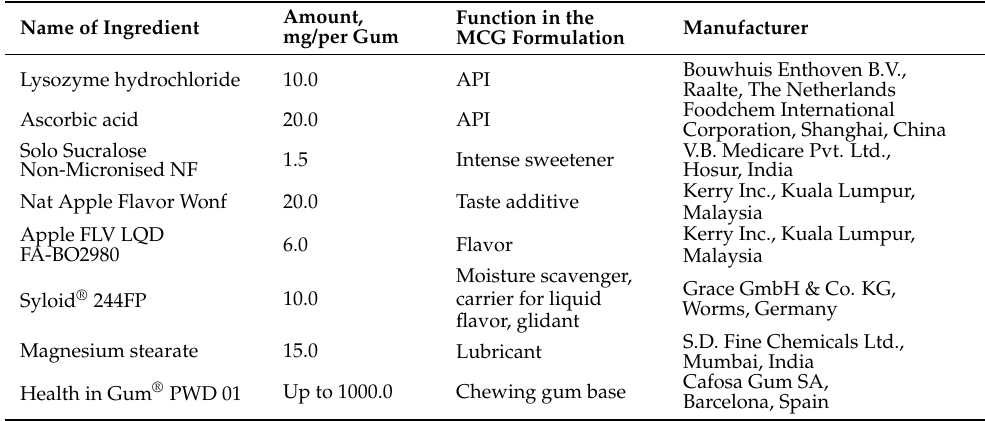
Table 1. APIs and excipients used to obtain MCGs. Name of Ingredient